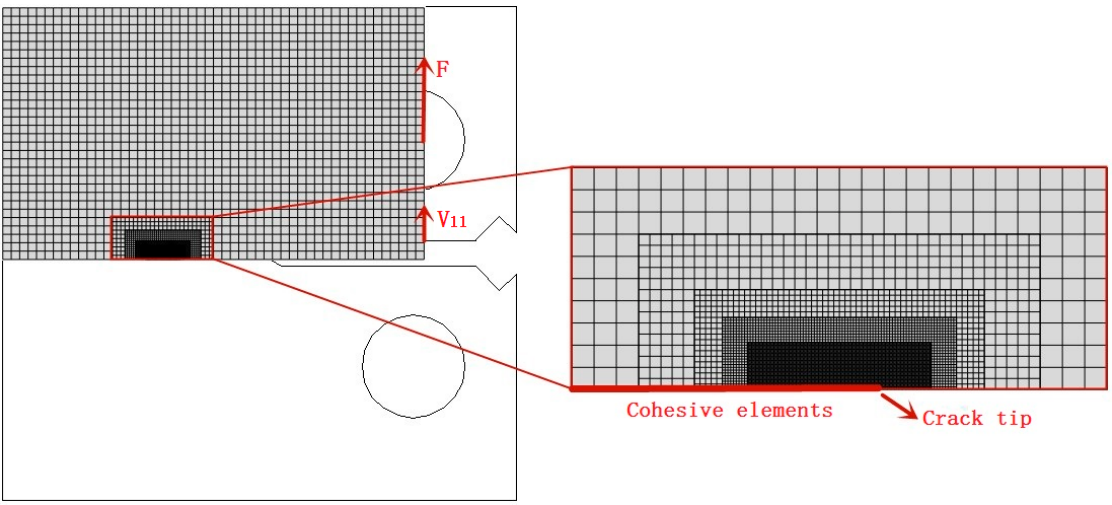
Figure 8. The finite element (FE) mesh (without the hole) structure around the initial crack tip. Table 2. Experimental true stress- plastic strain data for ABAQUS input analysis.